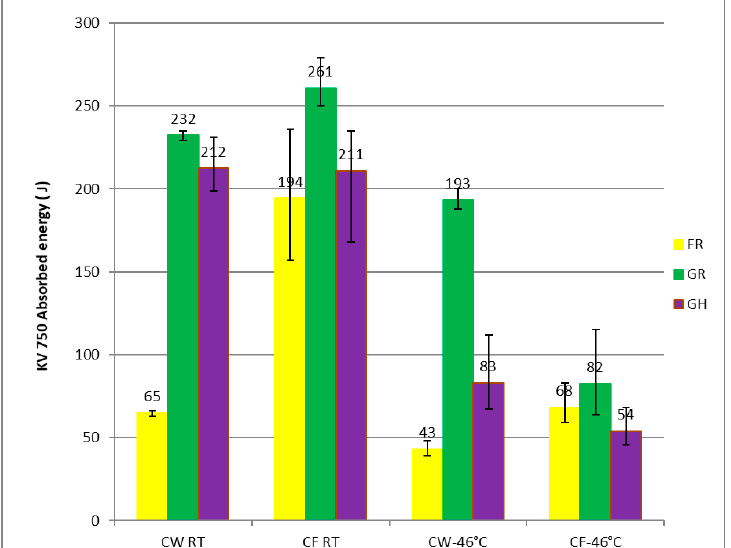
Figure 15. Charpy-V impact toughness results (CW: coupons extracted from the center of the weld